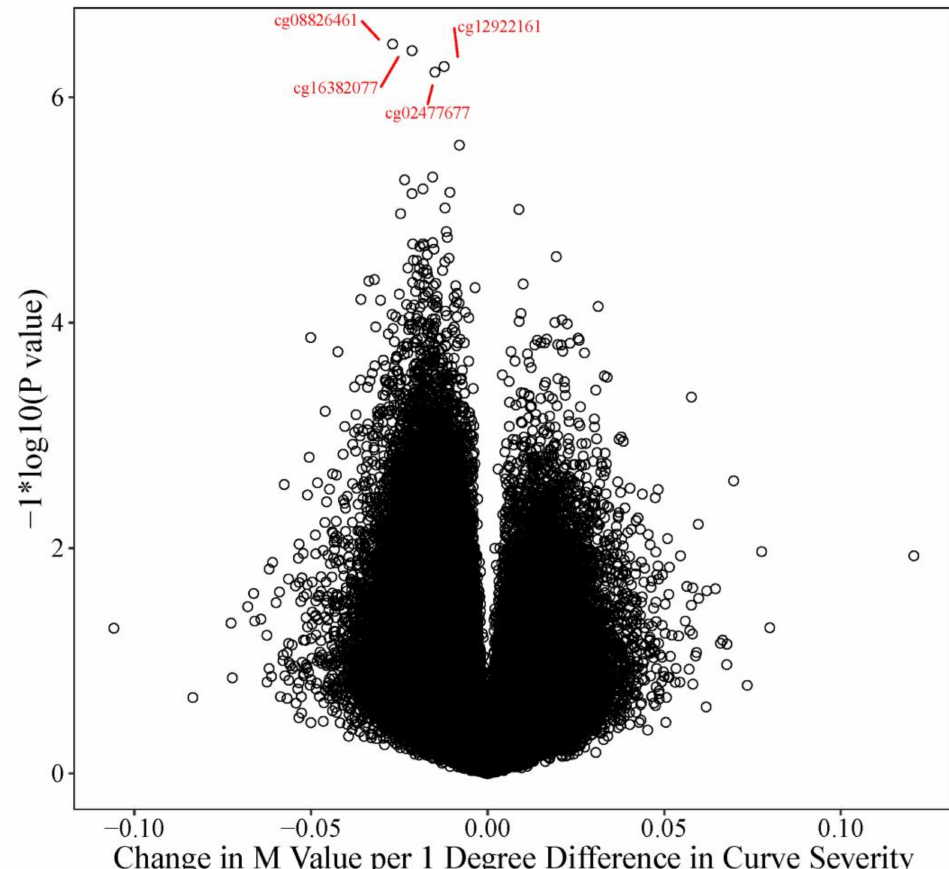
Figure 4. Volcano Plot: Curve Severity Analysis The volcano plot describes the effect size and p value for every probe tested in the curve severity analysis. The Y axis represents the − log10( p values) and the X axis represents the change in M value for every one-degree difference in curve severity between the twin pairs for each of the respective probes tested. Increasing curve disparity was more often associated with hypomethylation (decreased M values, left or negative side of the plot) than hypermethylation. The four FDR significant probes (FDR adj p = 0.0753) are highlighted in red, cg08826461 (nominal p value = 3.37 × 10 − 7 ), cg16382077 (nominal p value = 3.85 × 10 − 7 ), cg12922161 (nominal p value = 5.32 × 10 − 7 ), and cg02477677 (nominal p value = 5.97 × 10 − 7